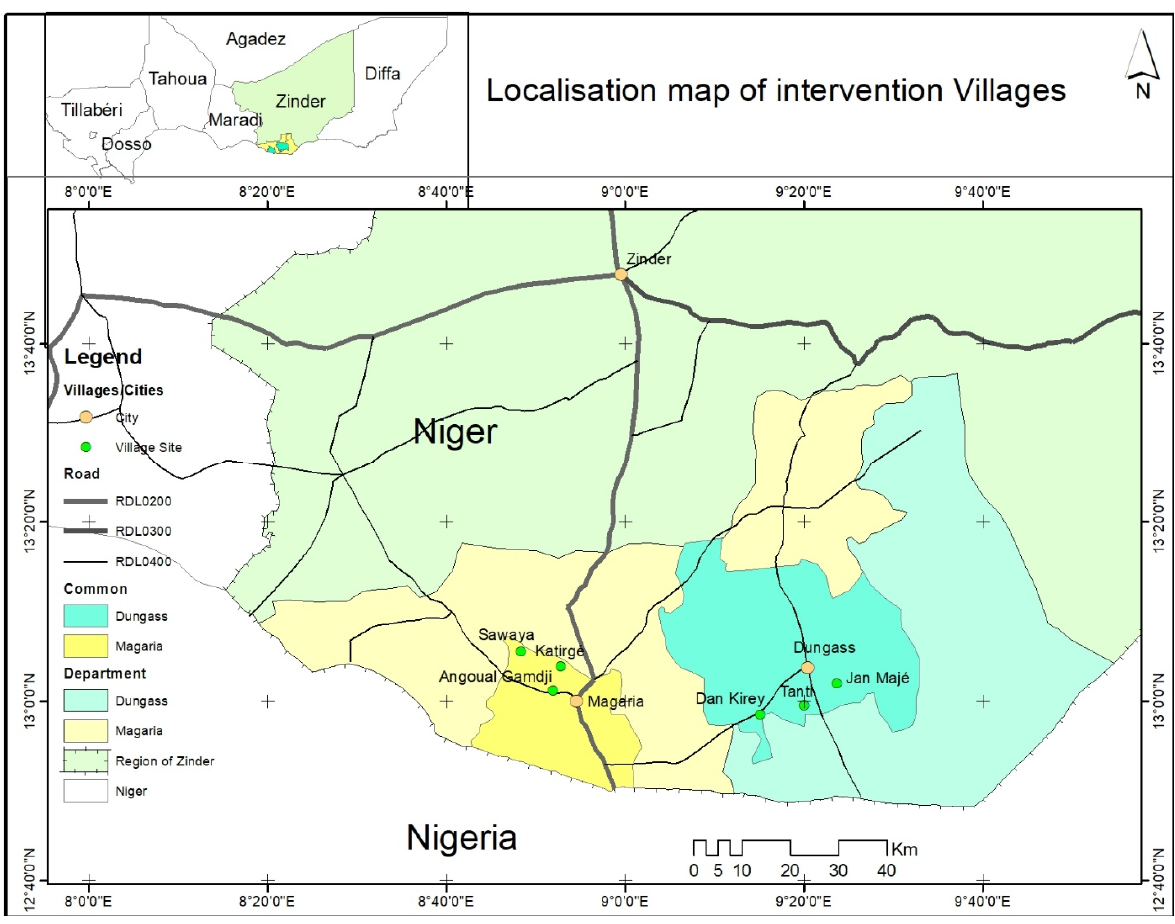
Figure 1. Sites of transplanting.